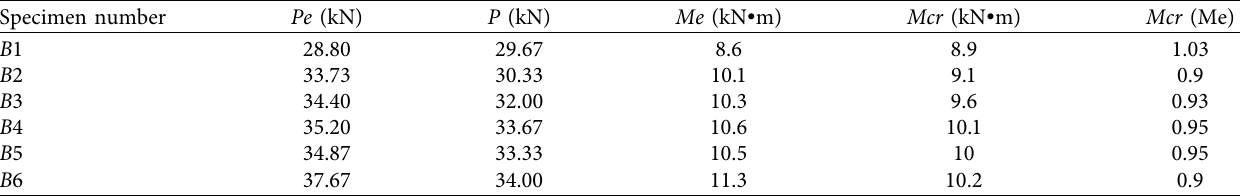
Table 6: Comparison of experimental and theoretical values of cracking bending moment.